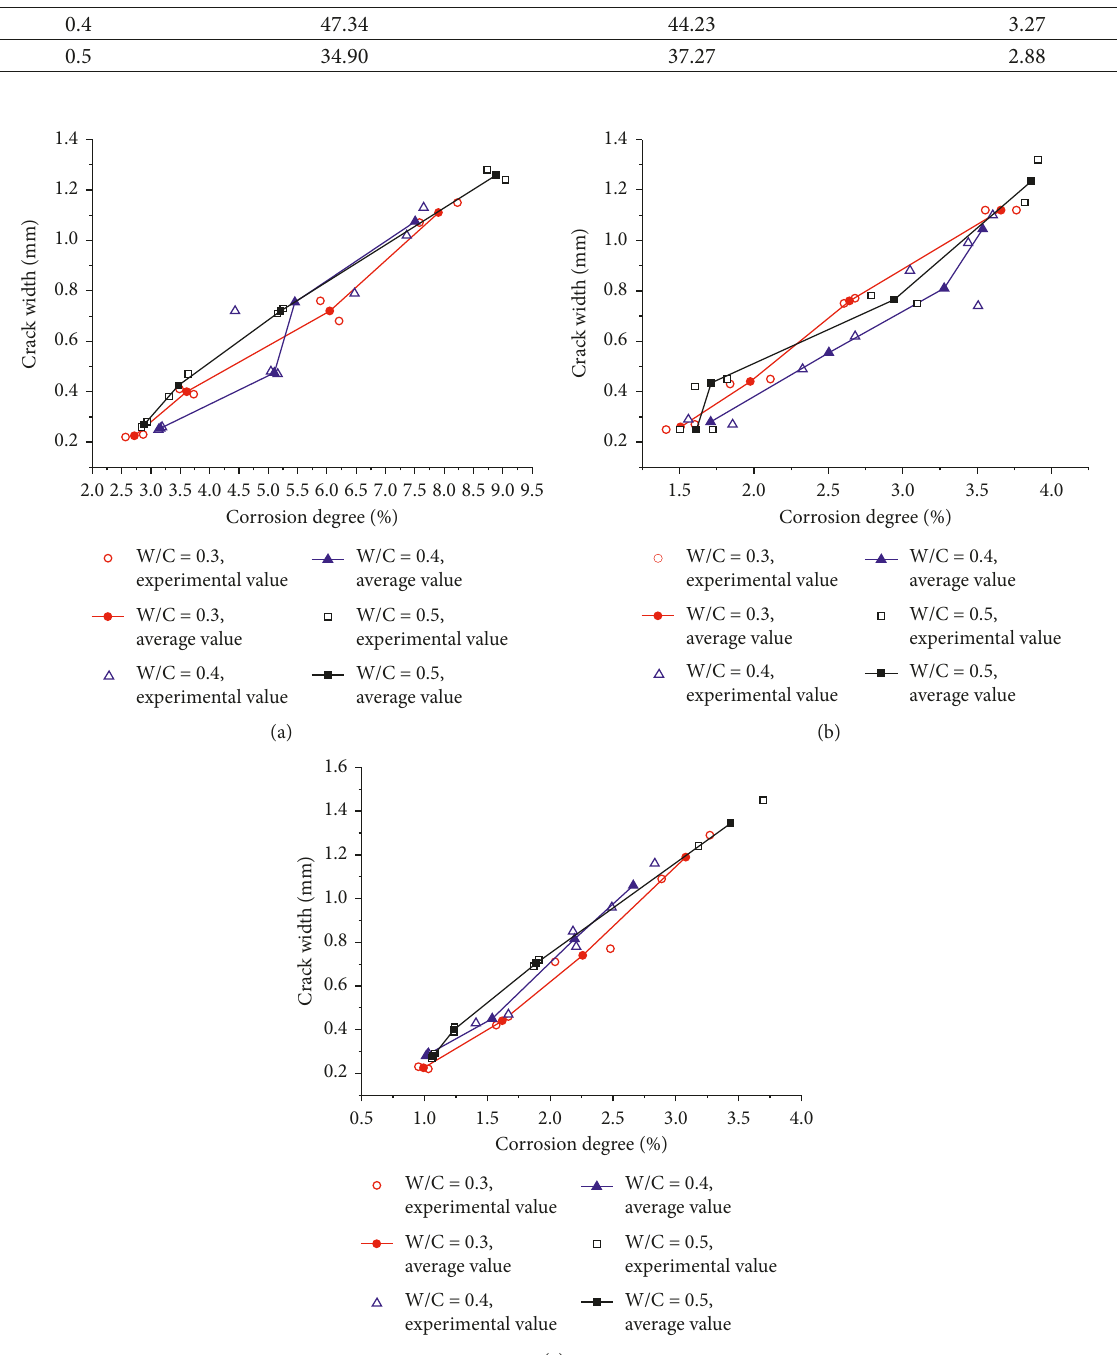
Figure 12: Effect of W/C on the relationship between cracking width and steel corrosion degree for different reinforcement diameters: (a) D � 12 mm; (b) D � 20 mm; (c) D � 25